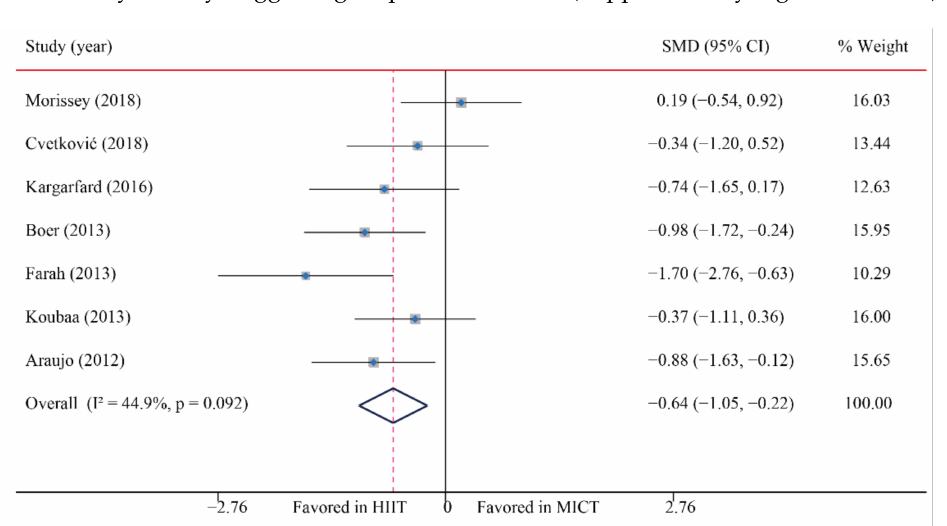
Figure 8. Effect of HIIT versus MICT on systolic blood pressure.